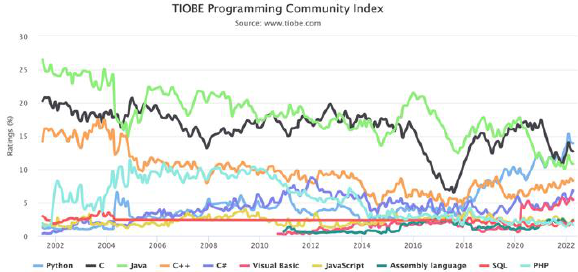
Figure 2 . TIOBE ( 9 ) index showing the most used programming languages since June